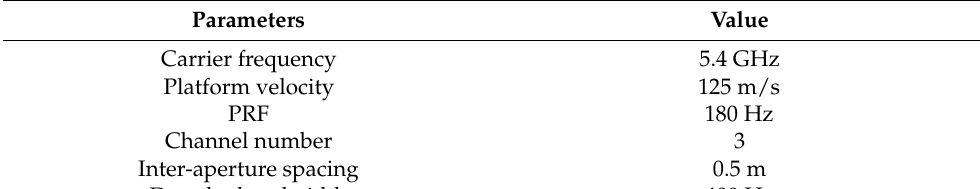
Table 3. Main parameters of real airborne data.